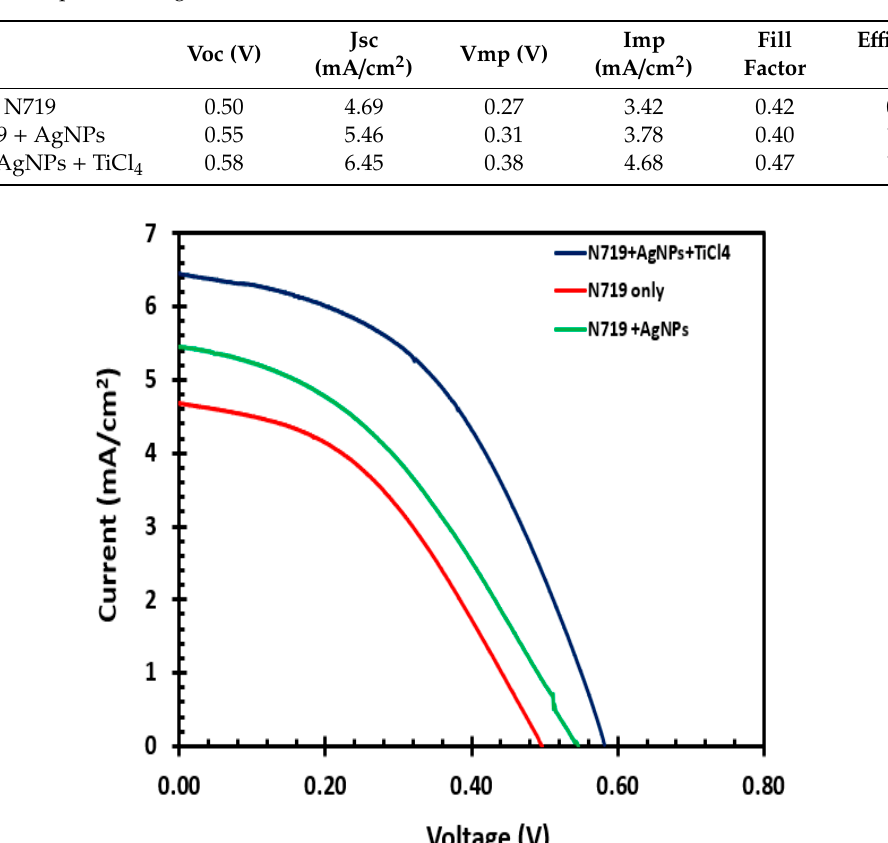
Figure 7. Current and voltage graph of DSSCs fabricated with only N719, N719, with AgNPs treatment, and N719 with AgNPs and TiCl 4 treatment.